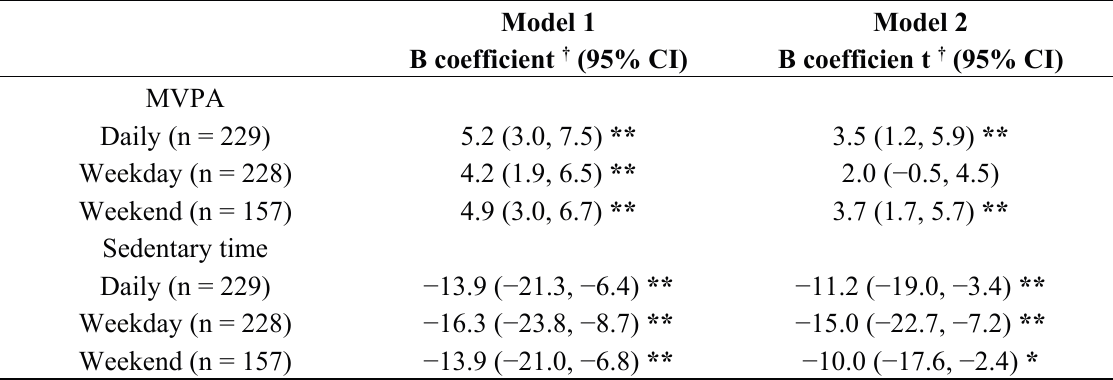
Table 2. Association between average daily, weekday and weekend light exposure (Log Lux) and time spent sedentary and in MVPA